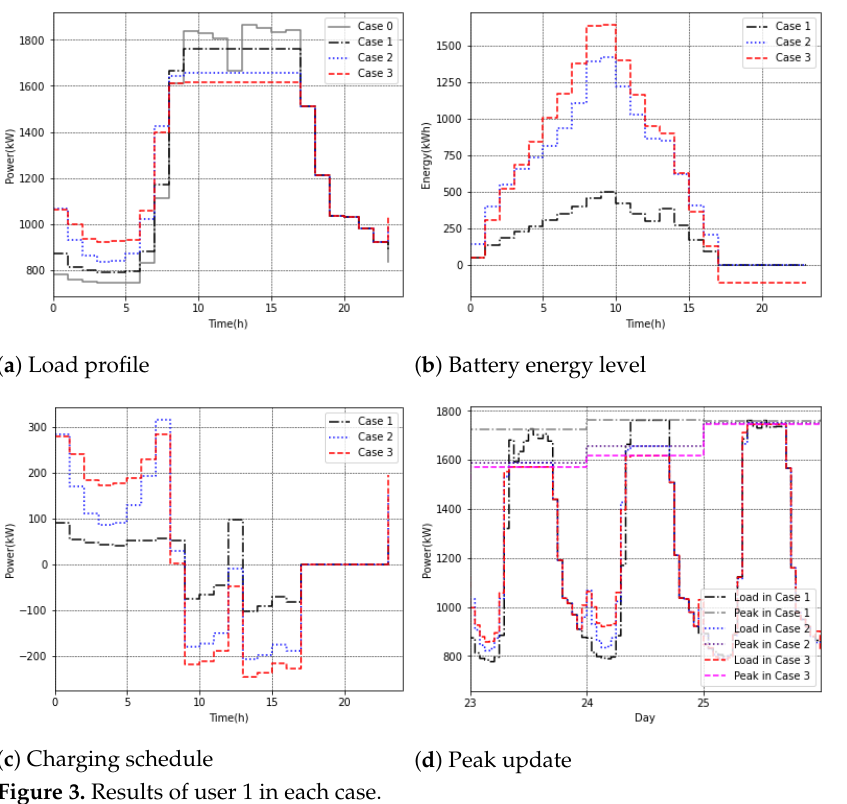
Figure 3. Results of user 1 in each